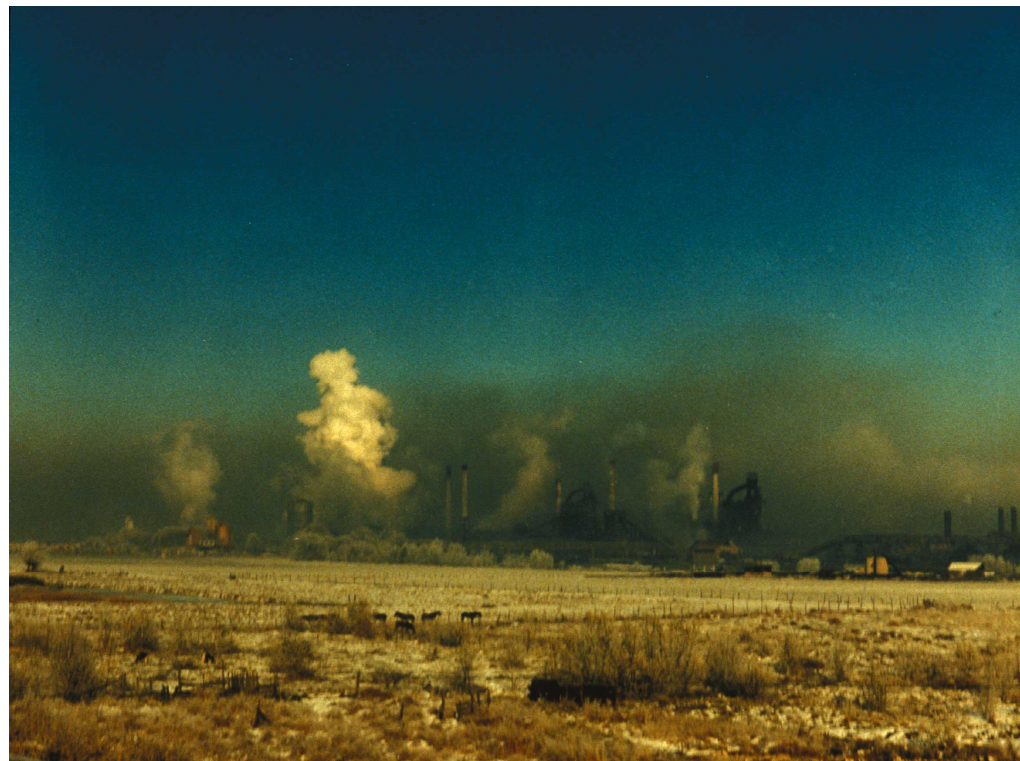
Figure 2. Photograph of Geneva Steel, Utah Valley, 1989 (PM 10 (particles < 10 µ m in aerodynamic diameter) approximately 150 µ g m − 3